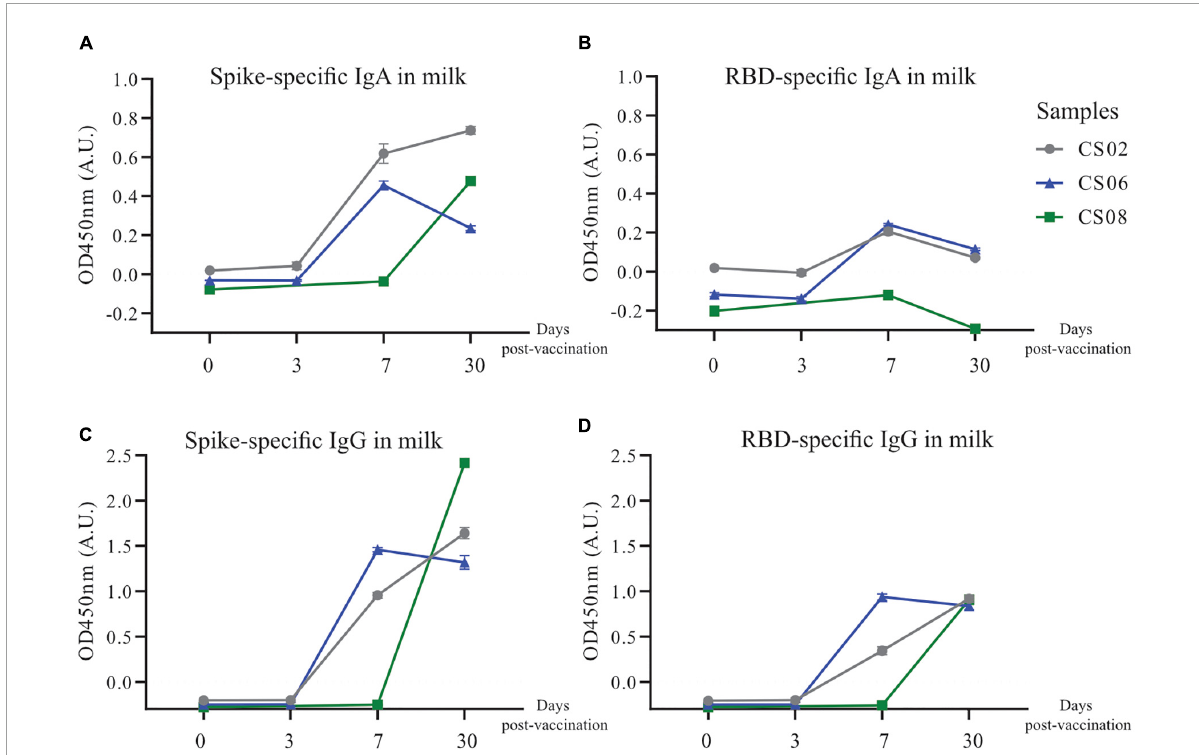
FIGURE5 Spike and RBD-specific IgA present in maternal breast milk of convalescent mothers. Using a protein-based ELISA, maternal breast milk from control (CT01- CT10) and convalescent (CS01-CS08) mothers obtained at two time points 0–1 months and 2–3 months post-partum were used for the detection of spike and RBD-specific IgG and IgA antibodies. Breast milk was screened for (A) spike-specific IgG, (B) RBD-specific IgG, (C) spike-specific IgA, and (D) RBD-specific IgA. The bar graphs represent the normalized average signals of antibodies binding to the respective proteins. Convalescent mothers (CS samples) are arranged in ascending order according to their time from COVID diagnosis to delivery.